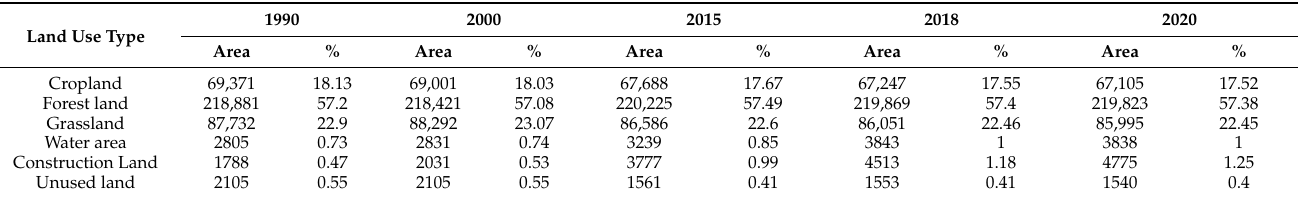
Table 2. Land use area and proportion in Yunnan Province from 1990 to 2020 (km 2